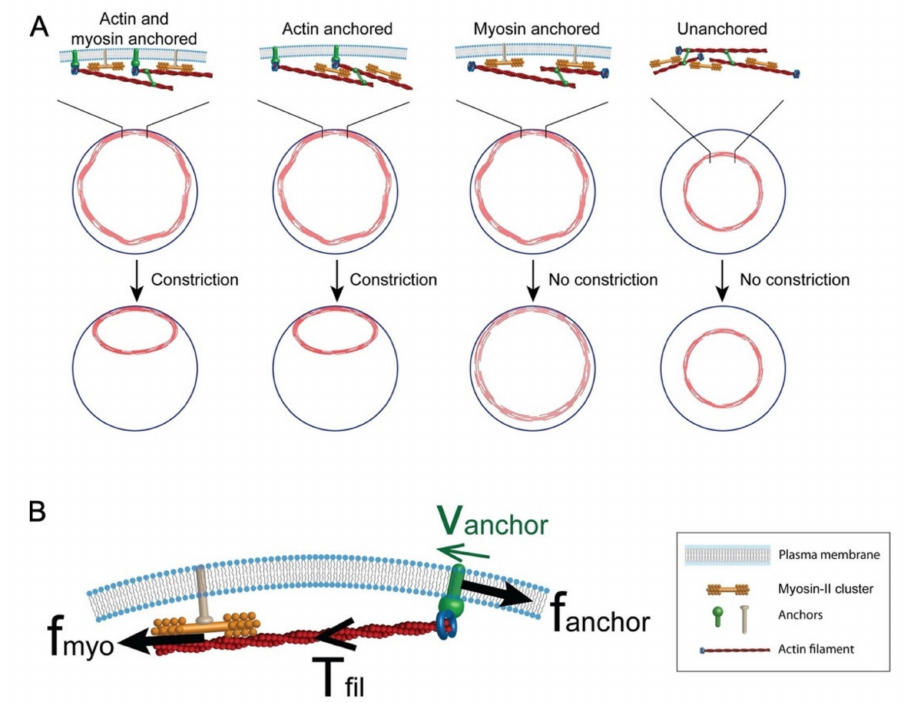
Figure 6. Model of cytokinetic ring attachment to the plasma membrane. ( A ) Simulation of cytokinetic rings showing that anchoring of actin to the plasma membrane is required for ring constriction. ( B ) An- choring is important to maintain myosin-generated tension in the actin filament as depicted by the force diagram. Used with permission from Wang & O’Shaughnessy (2019), Mol. Biol. Cell 30(16): 2053–2064. doi: 10.1091/mbc.E19-03-017 [91]; permission conveyed through Copyright Clearance Center,